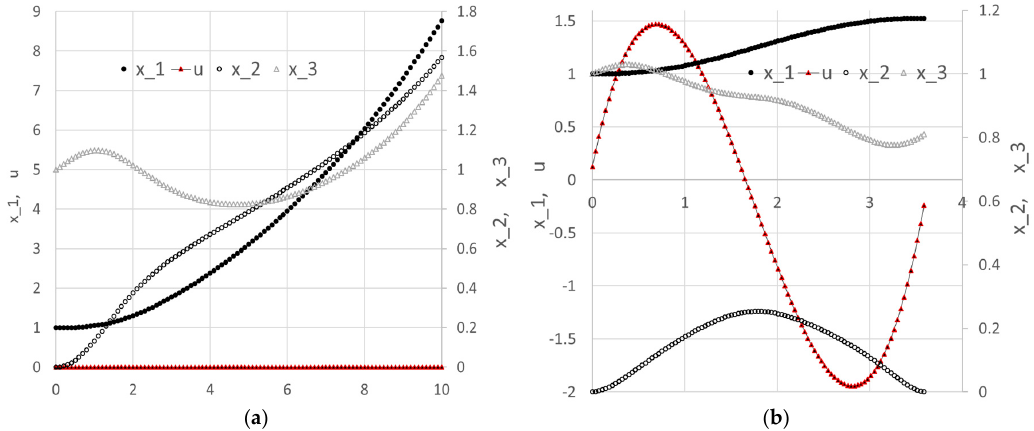
Figure 23. ( a ) Initial trajectories for optimal control problem (31)–(36) based on default values shown in Figure 20; ( b ) Optimal trajectories found by Excel’s NLP Solver.